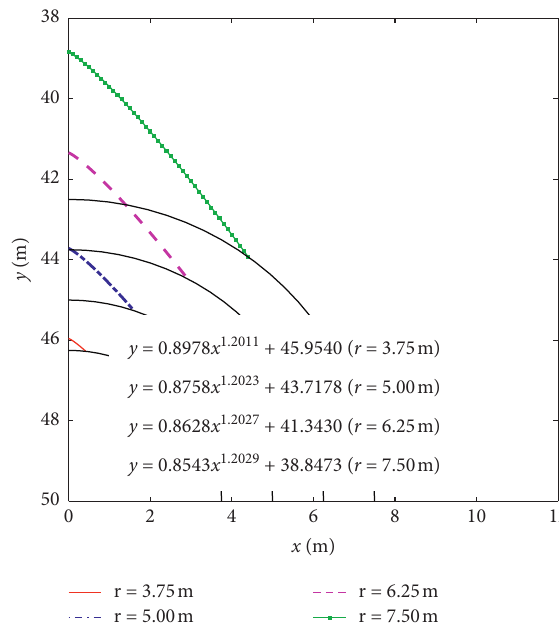
Figure 9: Effect of circular tunnel radius r on collapse mecha- nisms. The parameters are A � 0.35, B � 5/6, σ c � 3 × 10 4 kPa, σ t � σ c / t and compressive strength σ c � 28.33 kN/m 3 , and sat